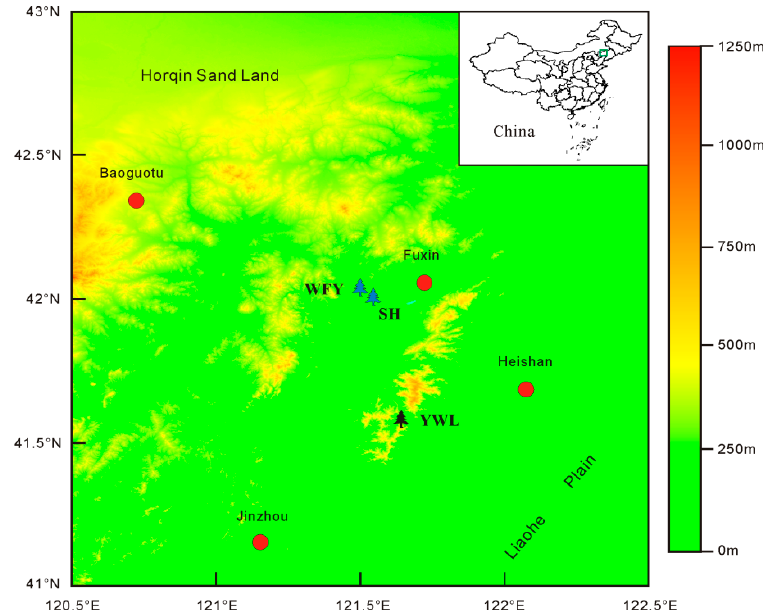
Figure 1. Locations of the study area (green rectangle), tree-ring sampling sites (blue tree, WFY and SH; black tree for comparison, YWL) and Fuxin meteorological station (red dot).